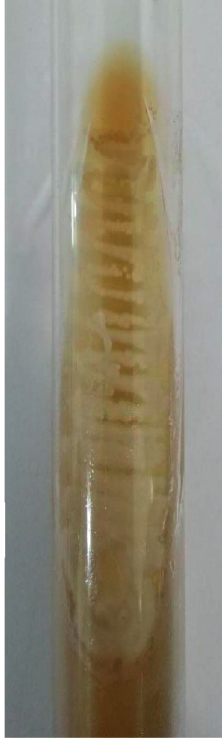
Figure 2: White to cream-colored, glabrous yeast-like colonies of W. anomalus were formed on SDA at 37 ° C after 24 hours of